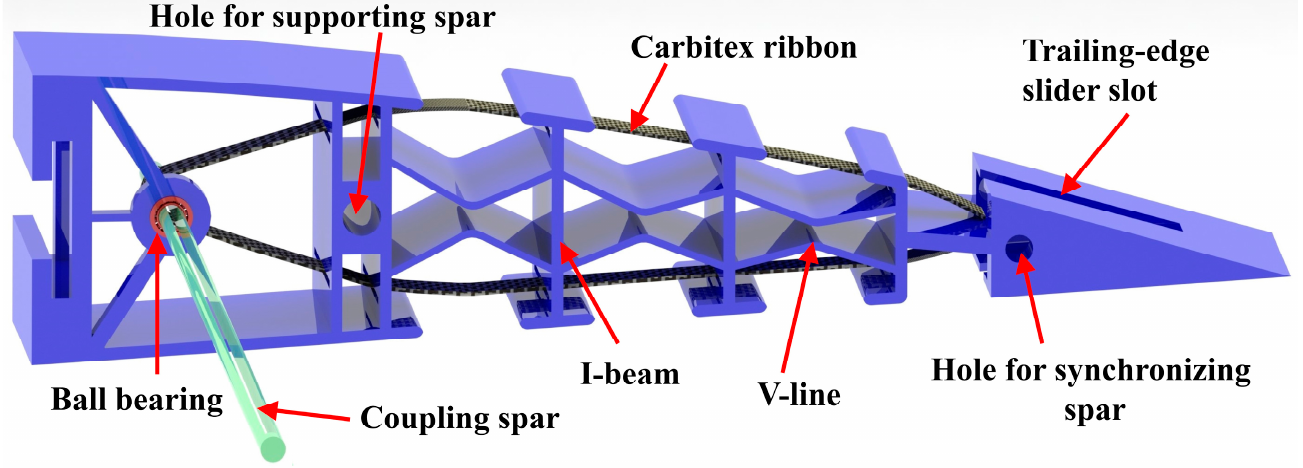
Figure 8. MM-3’s compliant trailing-edge section